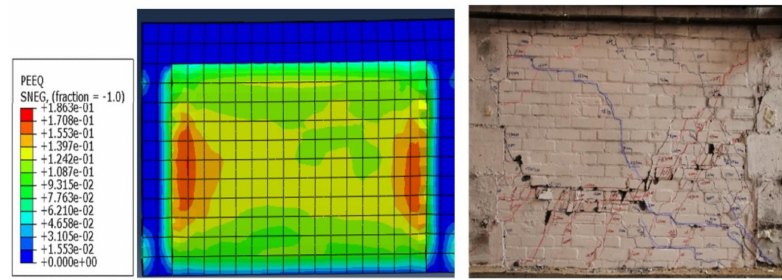
Figure 15. Diagram of equivalent plastic strain and fracture